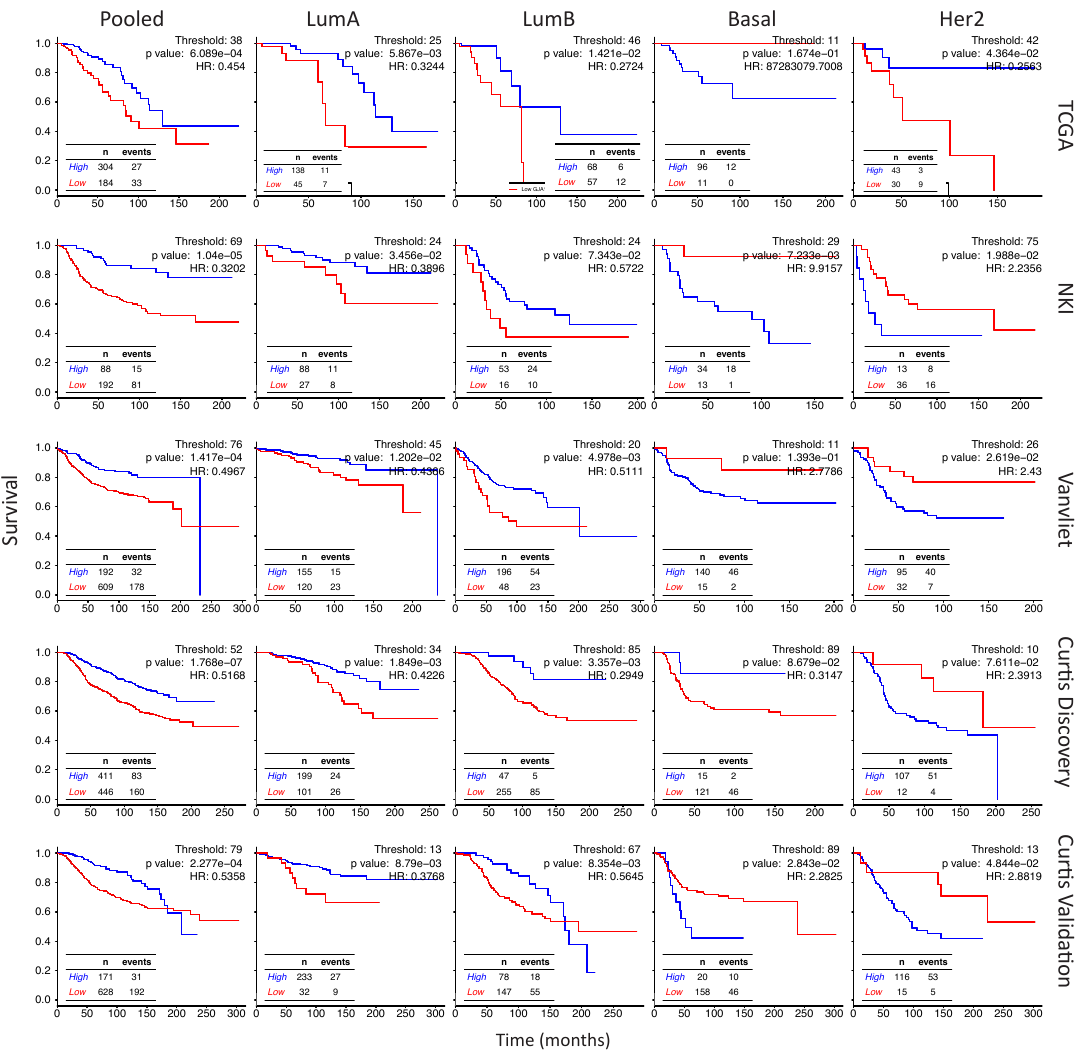
Figure A12. Survival analysis of GJA1 in individual subtypes of breast cancer with the cutoff selected according to the log rank test p value. The Kaplan–Meyer plot shows survival curves for patients with breast tumors expressing either high (blue) or low (red) levels of GJA1 mRNA in pooled tumors or in individual intrinsic subtypes. TCGA, NKI, Vanvliet and both Curtis datasets were used separately for the analysis. The best cutoff was determined as the percentile lending the lowest log rank test p value as in Figure